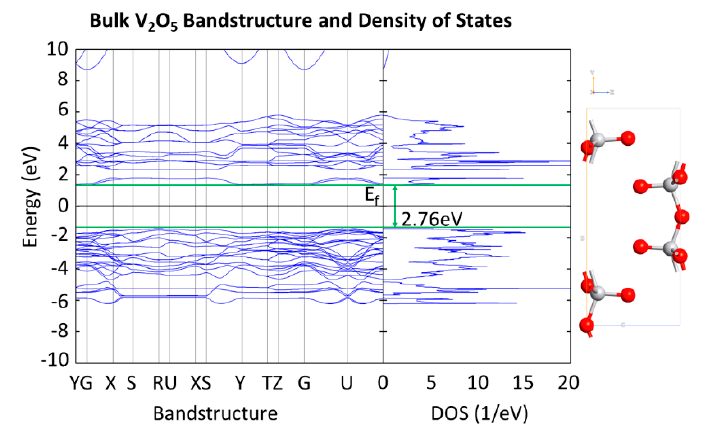
Figure 8. Bandstructure and DOS of bulk V 2 O 5 showing a band gap of 2.76 eV.